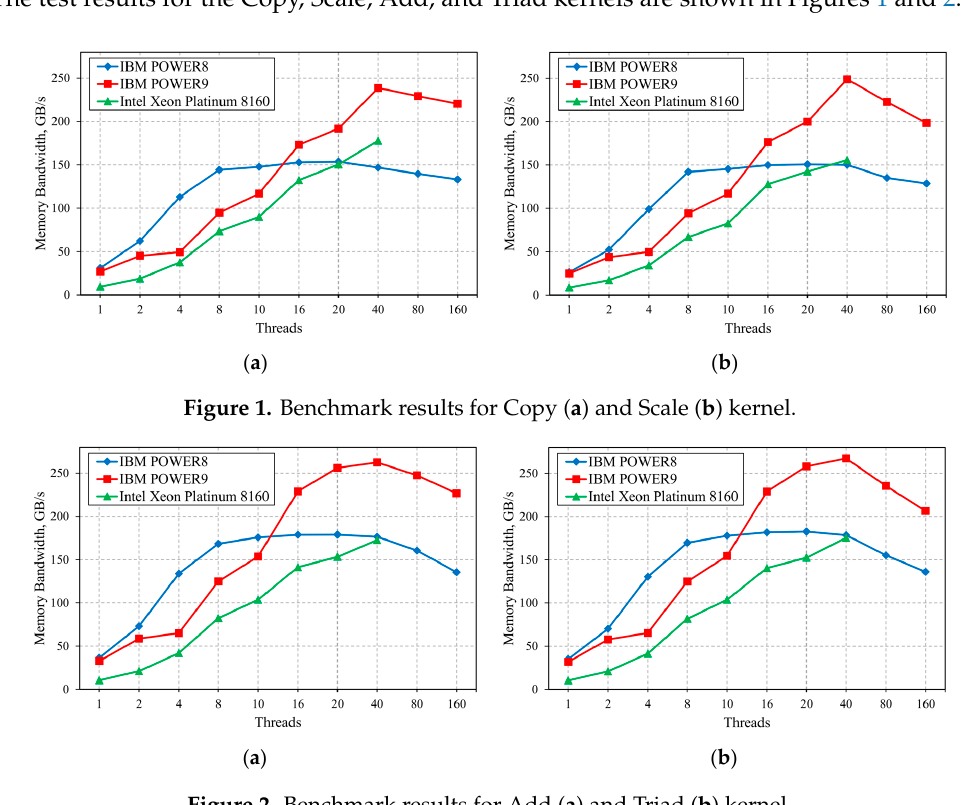
Figure 2. Benchmark results for Add ( a ) and Triad ( b ) kernel.